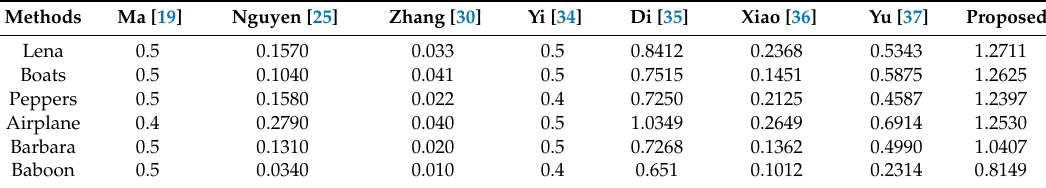
Table 3. Highest embedding capacity comparisons among di ff erent methods